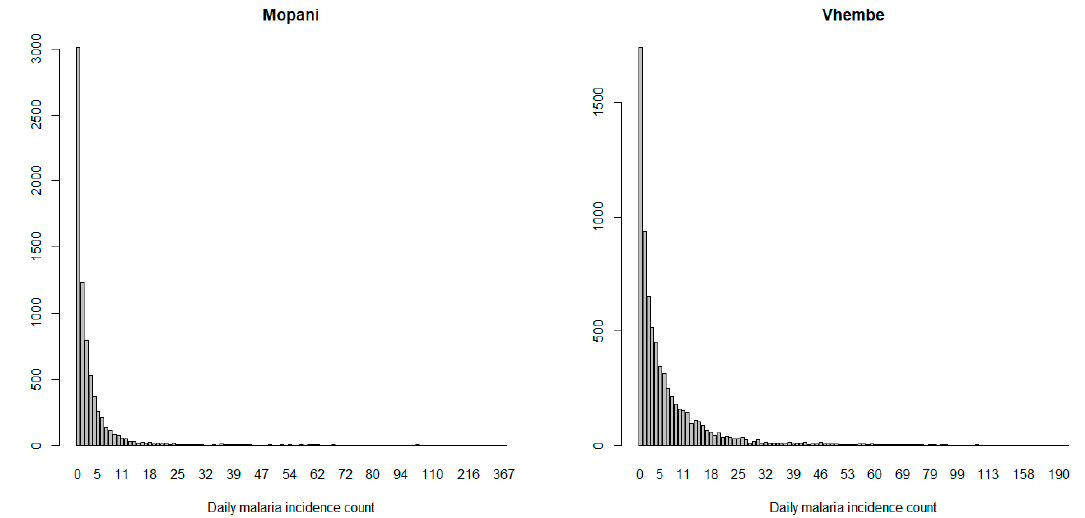
Figure 4. The barplot of malaria counts in Mopani and Vhembe district municipality, Limpopo province of South Africa.